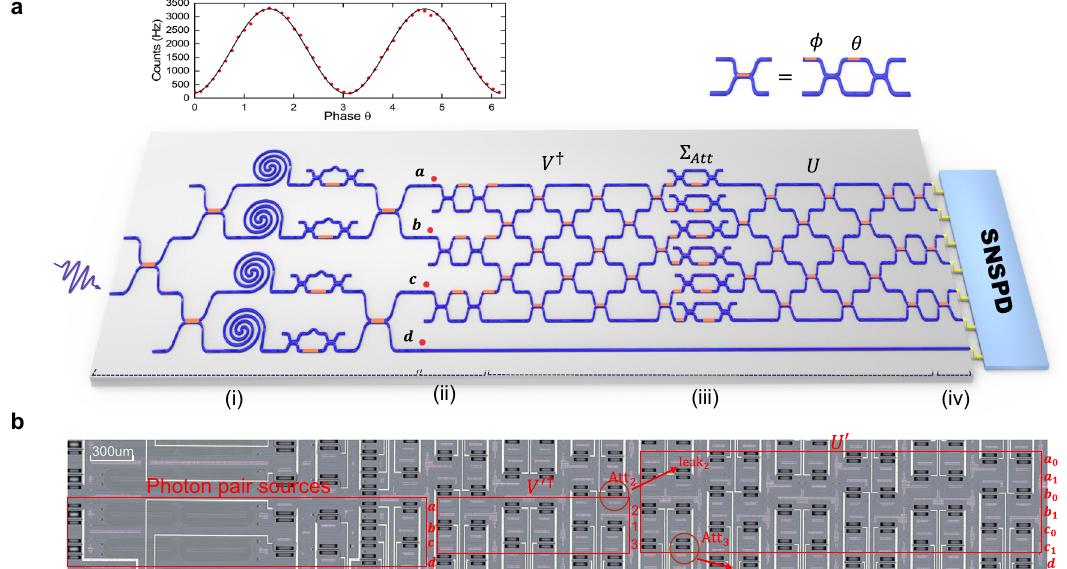
Fig. 2 Experimental realization of quantum logic gates. a A dual-wavelength pump beam is injected into the photonic chip composed of four parts: (i) the generation of two pairs of degenerated photons labelled as a, b and c, d via the interference of the N00N state; (ii) the (cid:1) (cid:3) preparation of initial states; (iii) the photonic circuit to realize the 6 × 6 nonunitary matrix Y ij by the SVD decomposition into three unitary matrices V y , Σ Att and U ; (iv) the measurement part at different bases. The photons at the outputs are coupled into fi bers and detected by SNSPDs. SNSPD: superconducting nanowire single-photon detector. Inset: The left subpicture is the results of the N00N state. At the angle θ ¼ π = 2 , the maximum coincidence counts mean one photon pair is generated at port a, b. The right subpicture is the construction of an MZI on chip which is composed of two multi-mode interferometers (MMIs) and two phase shifters. b The optical micrograph of the whole chip. In our chip, the 6 × 3 nonunitary matrix is divided into three parts: V 0y , the attenuation and U ′ . V 0y is a 3 × 3 unitary matrix, thus only two attenuations should be inserted in path 2 and 3 which are labelled as Att 2 and Att 3 . The attenuated photons are leaked out of the chip shown as leak 2 and leak 3 . The red box represents the main parts (i)-(iv) in our